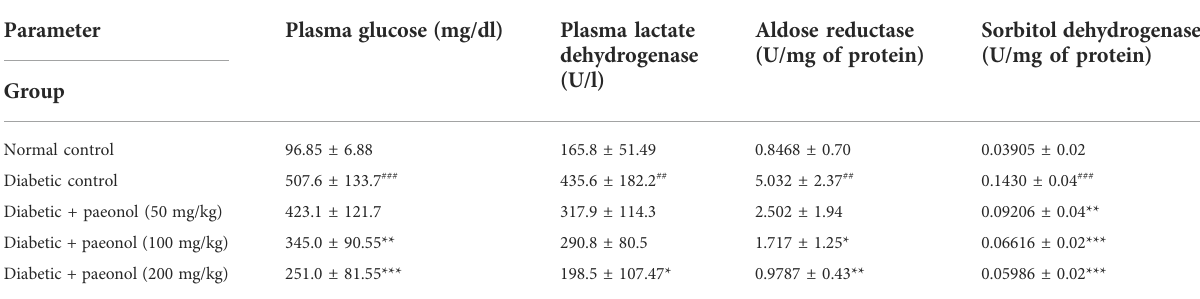
TABLE 1 Effect of paeonol on biochemical parameters.